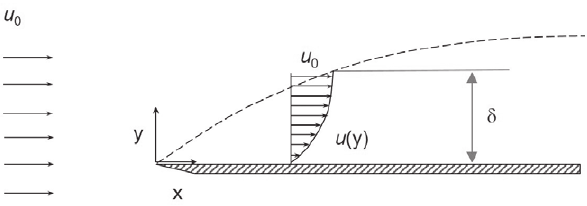
Figure 11. Schematic diagram of stationary or boundary-layer for- mation as a fluid flows over a flat solid surface (Adapted from David Weybourne